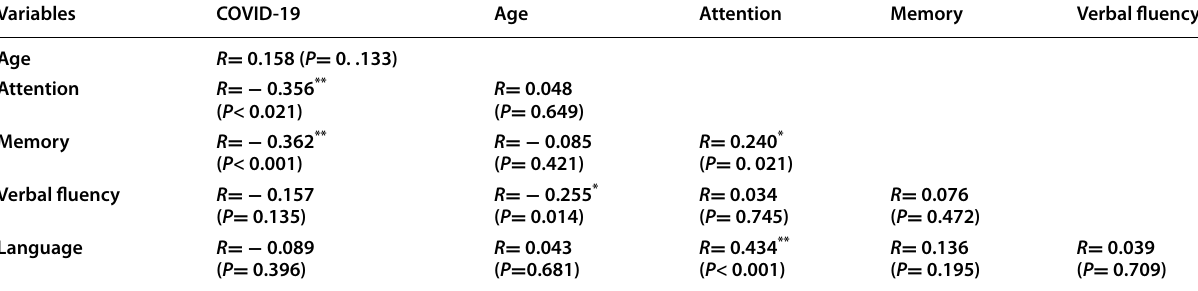
Table 7 Correlations between post‑COVID‑19, age, attention, memory, verbal fluency, and language scores